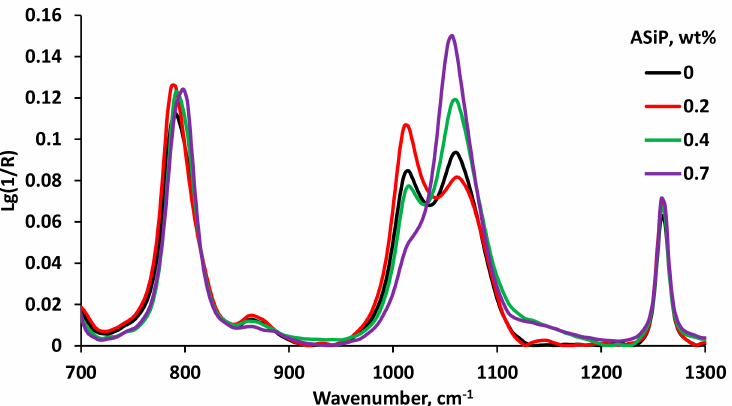
Figure 4. FTIR spectra of MBC based on [D 4 ]:[PPEG] = 15 obtained at different ASiP